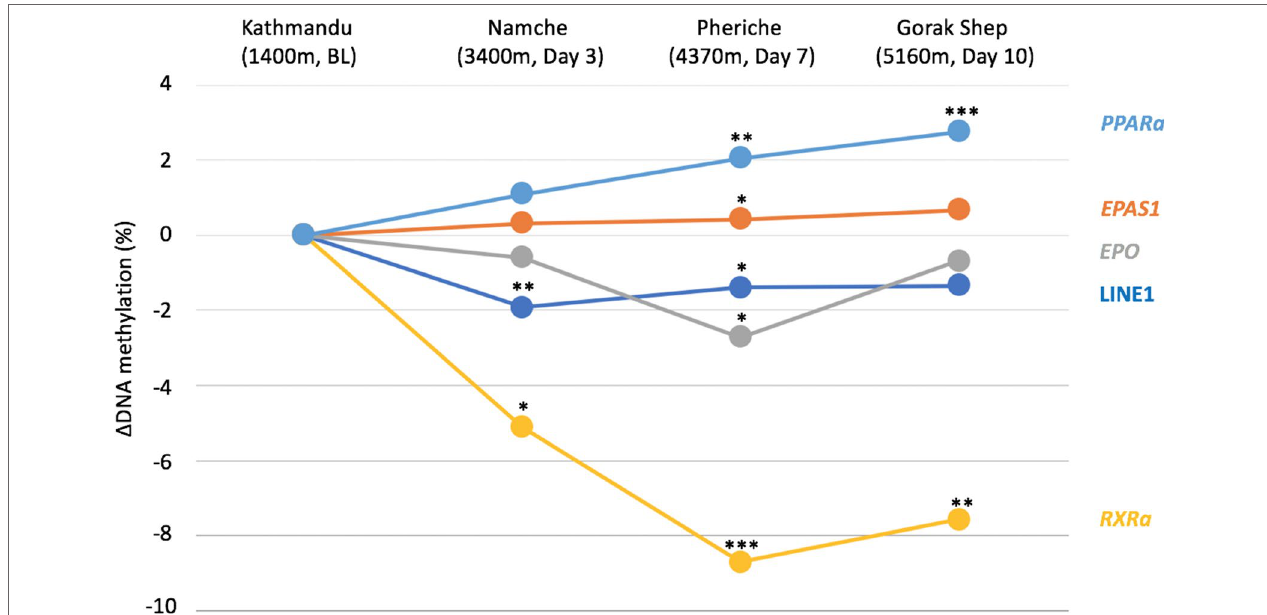
fIGURe 2 | DNA methylation difference between Kathmandu and each altitude is plotted for each gene over time. The baseline is Kathmandu, which is 0. Significance levels are shown by * p <0.05, ** p <0.005, *** p <0.001.